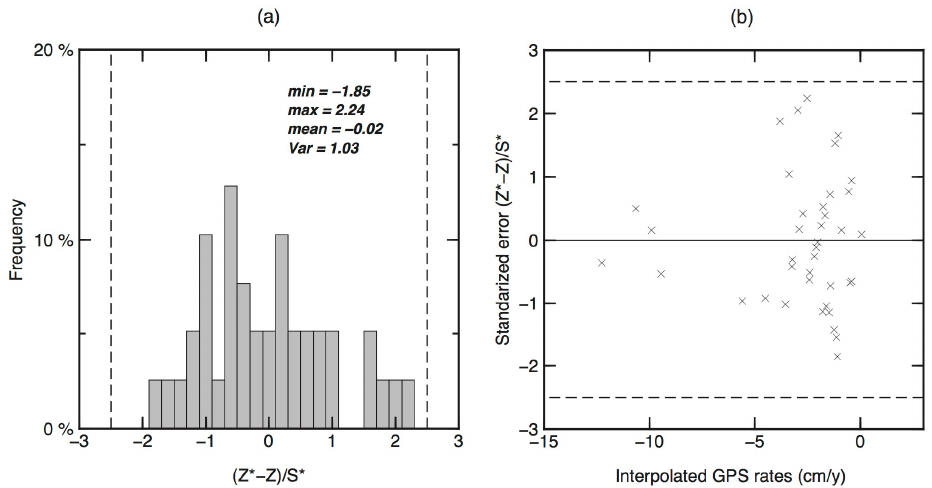
Figure 5. Cross-validation procedure for the GPS deformation rates’ interpolation. To characterize the ability of the interpolation to re-estimate (Z*) the data values (Z), errors are standardized by the predicted standard deviation ((Z* – Z)/S*). We define the interval [ − 2.5; 2.5] to focus on the 1% extreme values of a normal distribution. ( a ) Histogram of the standardized error. The minimum value, maximum value, mean value and variance are indicated. ( b ) Standardized error versus interpolated GPS rates in the 39 GPS locations.